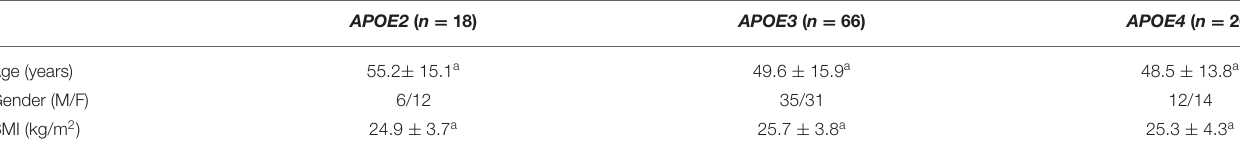
TABLE 1 | Basic characteristics of the study population at baseline based on APOE